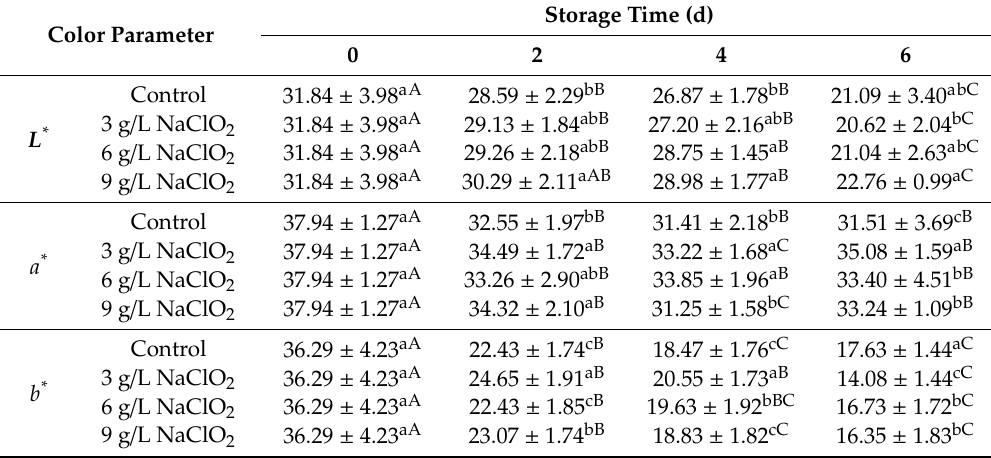
Table 2. Color parameters of strawberries packed in di ff erent corrugated cardboard boxes during storage at room